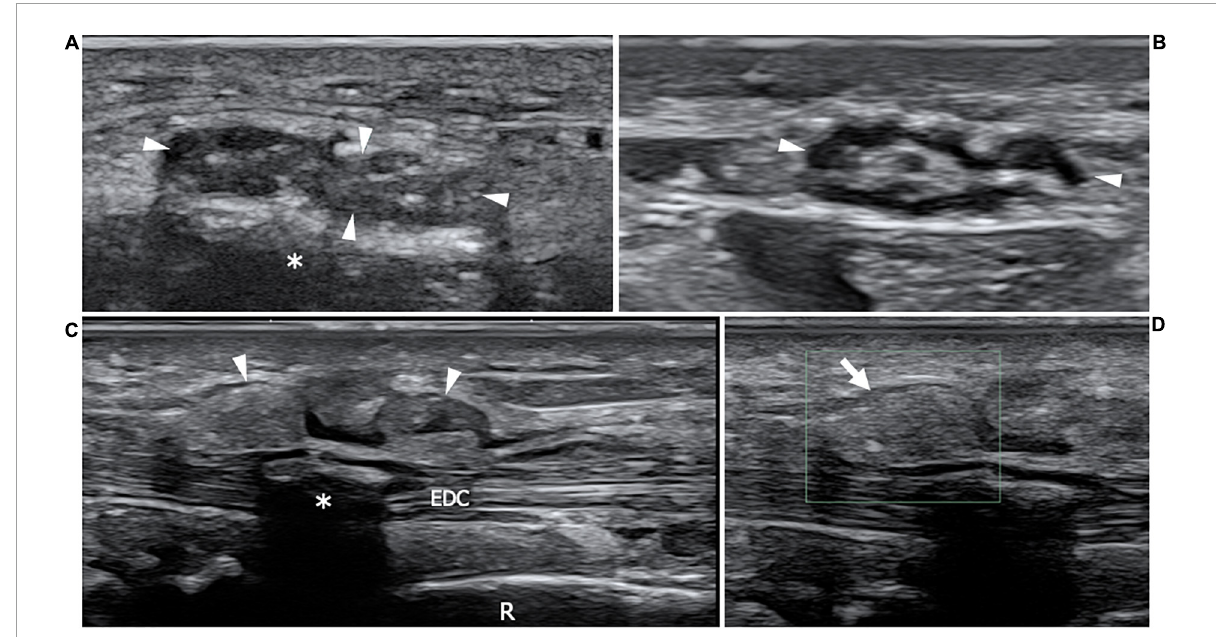
FIGURE9 This figure shows two 22 MHz HRUS images (A,B) and two 18 MHz HRUS images (C,D) of a 62 years old male affected by multiple myeloma who developed an AL amyloid arthropathy. (A) An axial view of the median nerve (white arrowheads), situated in the proximity of the flexor retinaculum is presented. The nerve appears enlarged, with clumped hypoechoic fascicles, a finding which is related to the compression due to the underlying amorphous, hyperechoic material (white asterisk); the nerve echotextural alterations become even more evident if the image is compared to the image in (B) where the median nerve (white arrowheads) is visualized in the short axis at a more cranial level in the forearm. (C) On the dorsal aspect of the same wrist, a huge distension of the extensor digitorum communis tendons (EDC) synovial sheath (white arrowheads) can be observed. At the Eco-Color Doppler evaluation showed in (D) , the inhomogeneous, hyperechoic material distending the tenosynovial sheath (white arrow) results avascular, a finding which is compatible with an intrasynovial amyloid deposition. White asterisk, intra-tendon calcification; R,